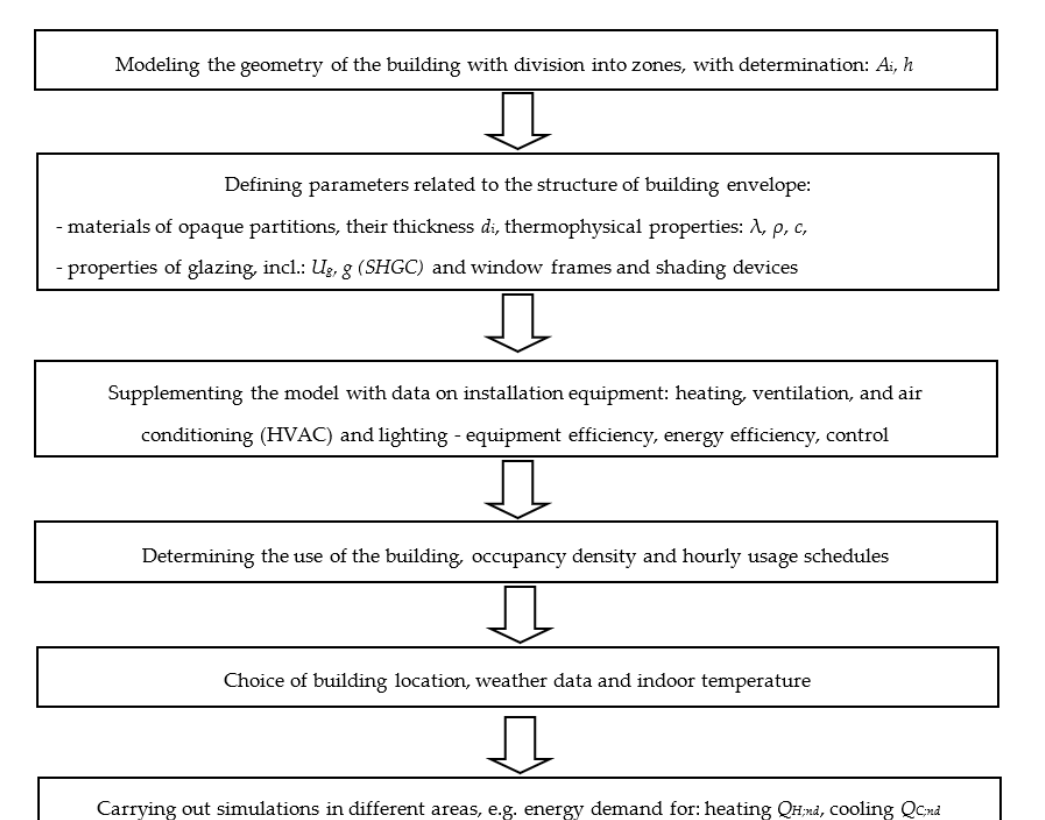
Figure 3. Block diagram of calculations performed in DesignBuilder (own elaboration based on [27,28]), where A i is the area of individual partitions, h is the height of the story in the building, d is the thickness of the partition layer, λ is the conduction coefficient, ρ is the material density, c is the specific heat of materials, U g is the heat transfer coefficient of glazing, and g is the total solar trans- mittance.